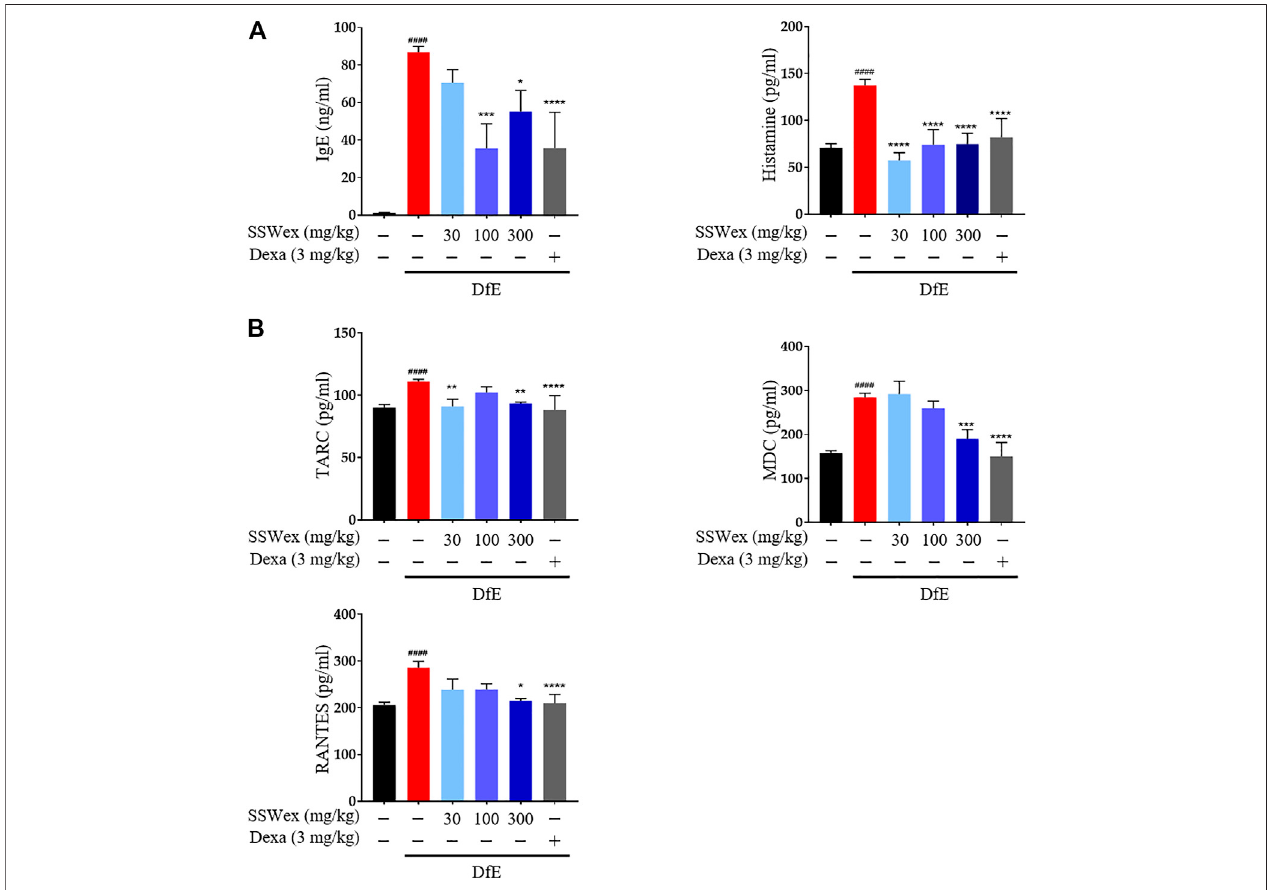
FIGURE 4 | Effect of SSWex on serum immunoglobulin E (IgE), histamine, and proin fl ammatory chemokine levels in DfE-induced atopic dermatitis (AD) – like skin lesions in NC/Nga mice. The serum samples were collected on the last day of the experiment. The serum samples were diluted ×100 times and analyzed. (A) Total IgE and histamine levels in serum were detected using ELISA. (B) Levels of proin fl ammatory chemokines (MDC, RANTES, and TARC) were determined using ELISA. Data are expressed asthemean±S.E.M.( n =6). # p < 0.05, ## p < 0.005, ### p < 0.0005,and #### p < 0.0001vs. thenormal group; * p < 0.05, ** p < 0.005, *** p < 0.0005, and **** p < 0.0001 vs. the DfE